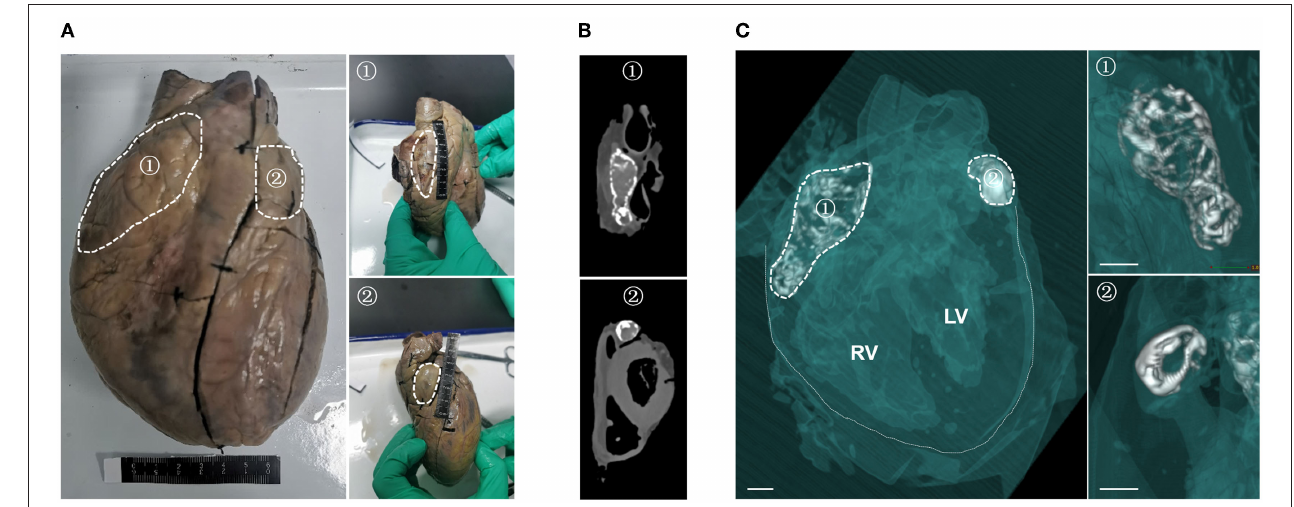
FIGURE 1 | Symmetrical distribution of two calcifications in the left and right atria of this patient. (A) Gross examination of the heart, showing two hard, palpable calcifications in the left ( › ) and right ( ‹ ) atrial chambers. White dashed lines show the outlines of the two calcifications. (B) Computed tomography scan showing the two calcifications in the patient’s heart. (C) 3D reconstruction of the heart specimen from the patient from the left oblique frontal view. Soft tissue (myocardium, congestion and blood vessel) is semitransparent green in color, calcium density is white and air density is clear. The solid white lines in the left panel delineate the boundaries of the heart, and the white dashed lines delineate the outlines of the two calcifications. Structural details of the two calcifications are magnified in the right panel. Scale bar =